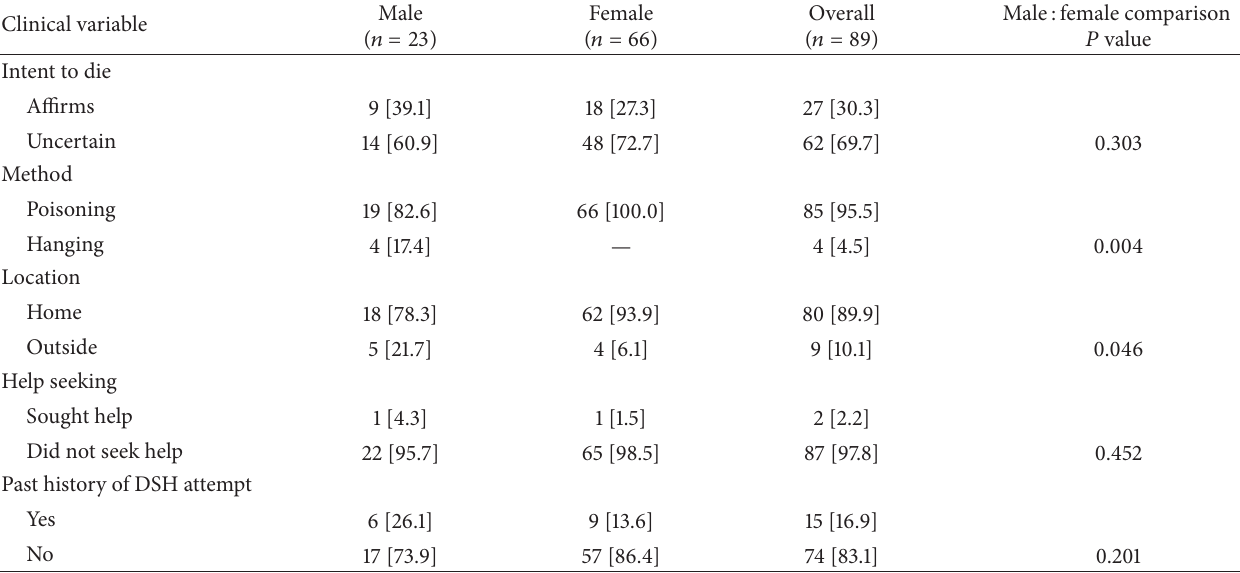
Table 1: Summary of issues related to the deliberate self-harm act in the study